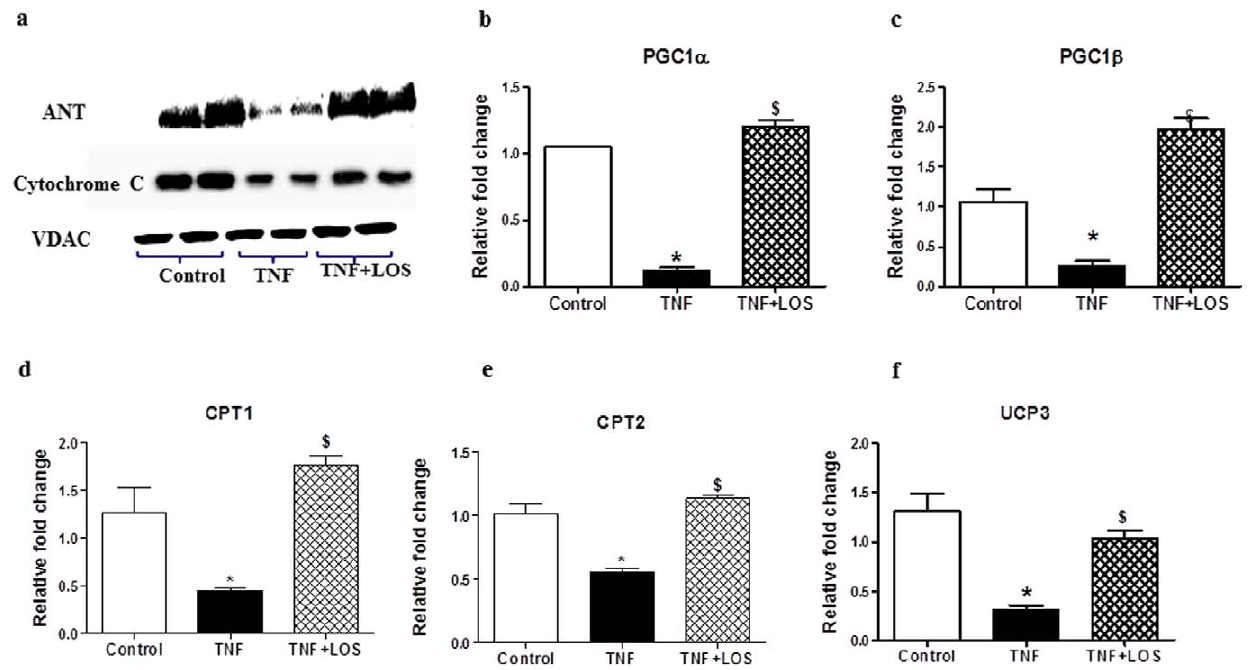
Figure 5. Representative western blot analysis of a left ventricle showing changes in expression of MPTP proteins from isolated mitochondria. TNF treated rats exhibited a significant decrease in adenine nucleotide translocator (ANT) and cytochrome C content when compared with the control and TNF + LOS groups. In the TNF + LOS treated group, ANT and cytochrome C protein levels were normalized (Fig 5a). Mitochondrial gene expression levels for b) PGC1 a , c) PGC1 b , d) CPT1 b , e) CPT2, and f) UCP3 were all significantly decreased in animals given TNF; concomitant treatment with LOS attenuated these changes. * p , 0.05 vs. control; $ p , 0.05 vs.TNF.